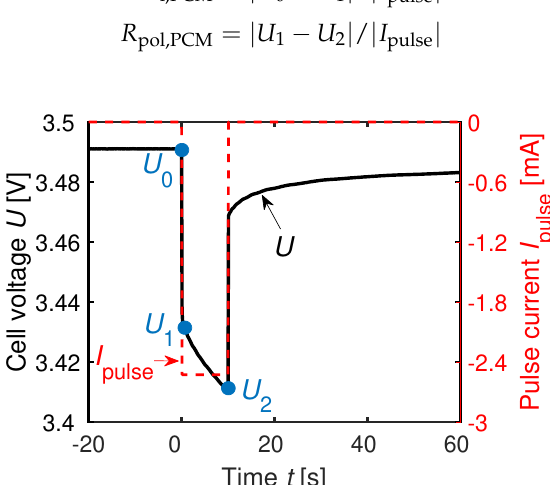
Figure 4. Characteristic shape of cell voltage U for an applied current I pulse . Data used from the PCM are defined in Equations (8) and